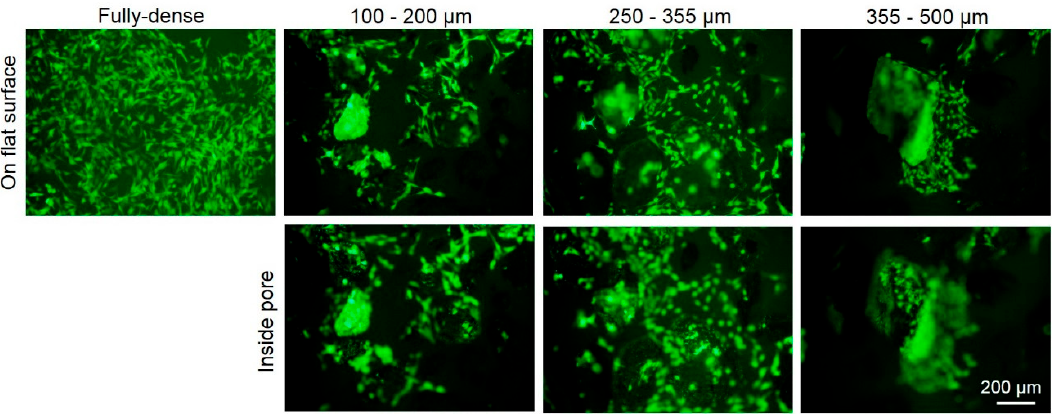
Figure 7. Higher magnification of microphotographs of C2C12-GFP cells growing after day 4 of cell incubation. Common scale bar.